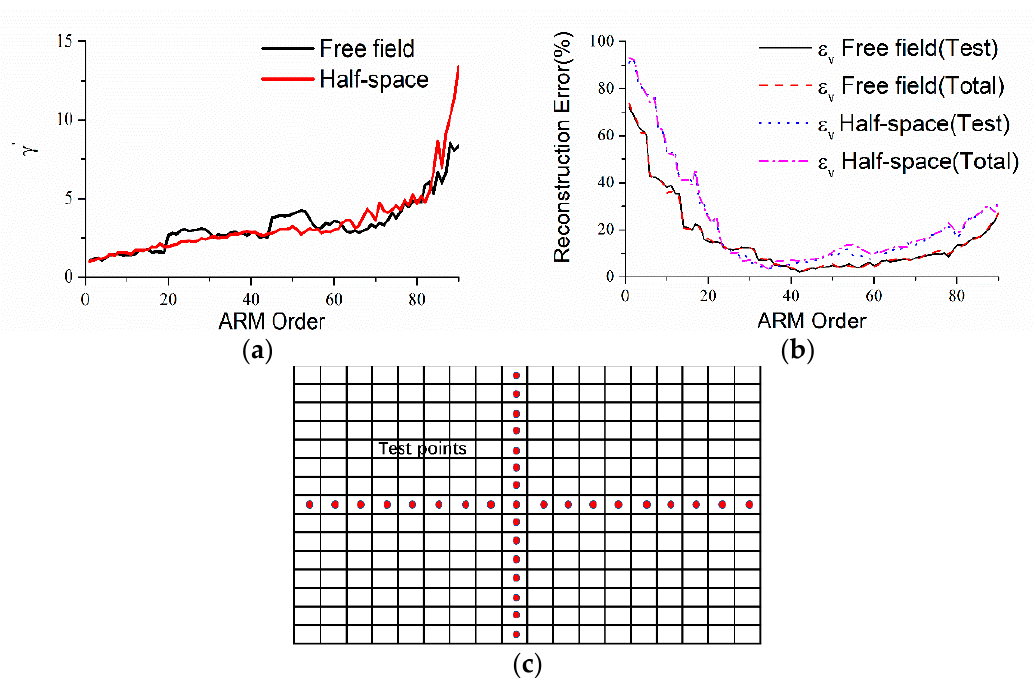
Figure 12. ( a ) The variation of γ (cid:48) with the increase of ARM order, ( b ) the variation of reconstruction error versus the ARM order ( 𝑓 (cid:2868) = 71 Hz , ℎ (cid:3022) = 0.2 m ), and ( c ) the arrangement of test points.